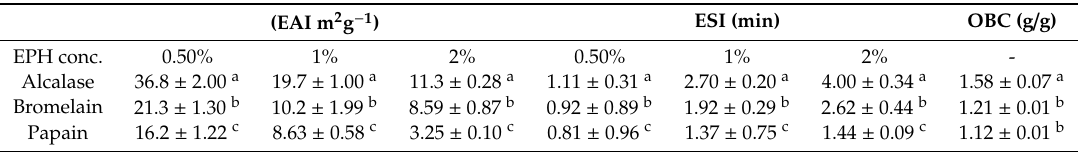
Table 3. Emulsifying activity index (EAI, m 2 g − 1 ) and emulsion stability index (ESI, min) at di ff erent EPH concentrations (0.5%, 1%, and 2% w / v ) and oil binding capacities (OBC, g /